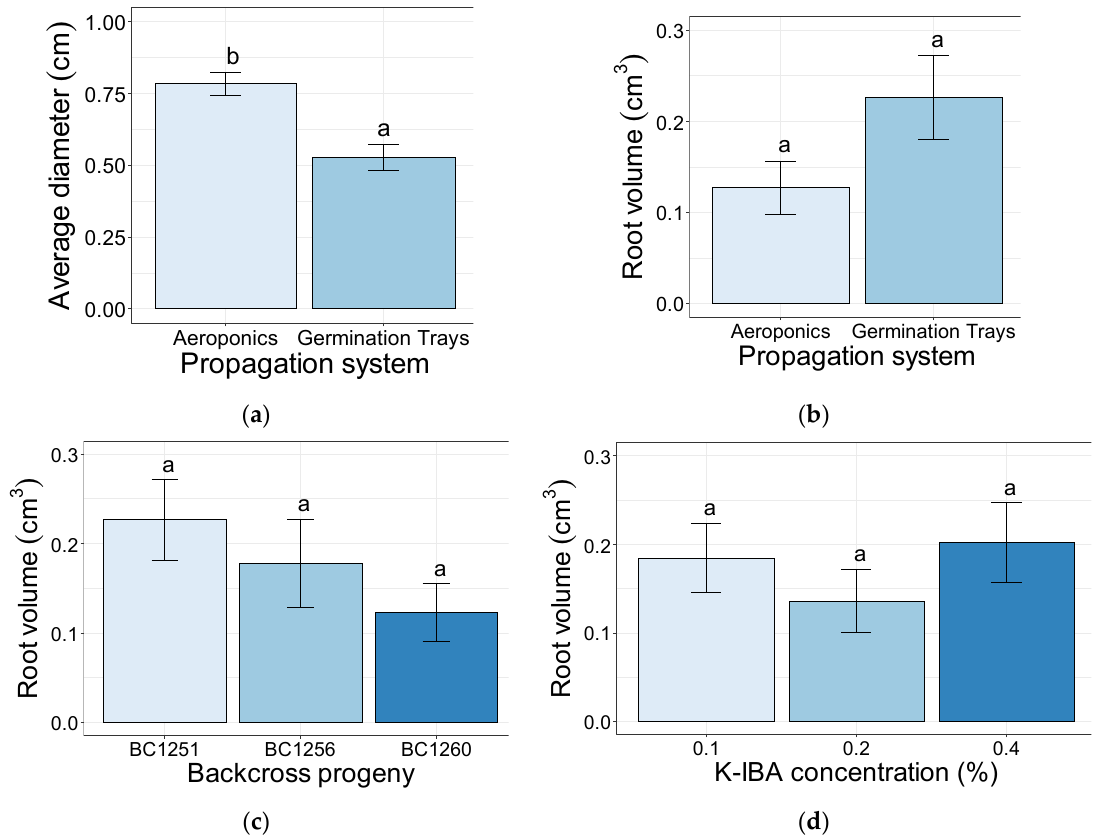
Figure 6. Root average diameter (cm) after 35 days of rooting of the softwood cuttings rooted in aeroponics systems and germination trays ( a ) and their root volume (cm 3 ) comparing propagation systems ( b ), backcross progenies ( c ), and K-IBA concentrations ( d ). Bars bearing the different letters are significantly different at p < 0.05.